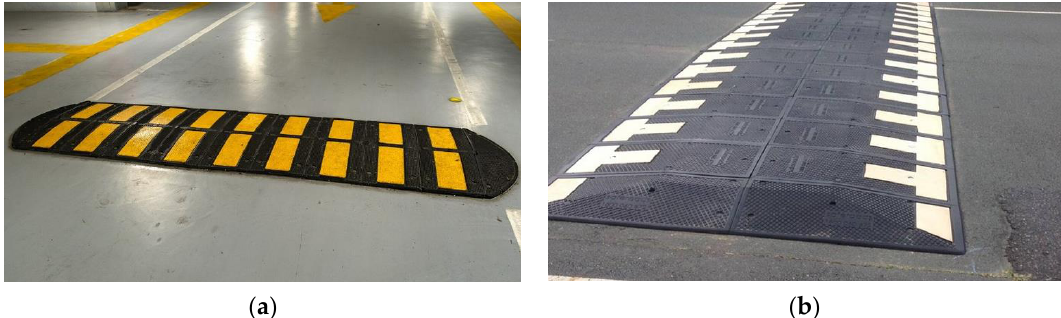
Figure 16. Shapes of the profiles limiting speed of moving vehicles: ( a ) speed bump A, ( b ) speed bump B.